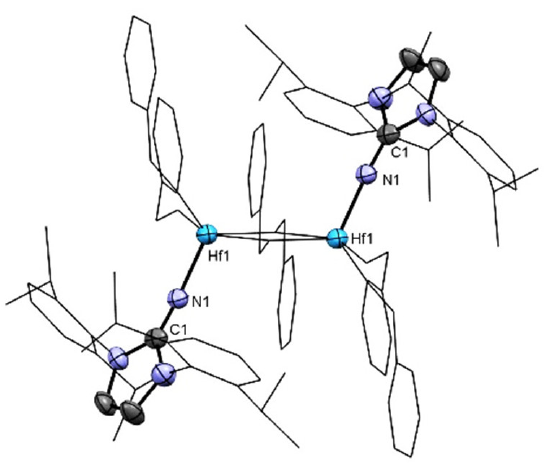
Figure 4. ORTEP drawing of 5 [(Im Dipp N) 2 Hf 2 (OBn) 6 ]. Hydrogen atoms are omitted for clarity. Selected bond lengths (Å) and angles (°): Hf-N1 = 1.971(7), Hf-O1 = 2.136 (5), Hf1-O1 = 2.198(6); Hf-O2 = 1.936(6), Hf-O3 = 1.958(7); N1-C1 = 1.251(10) Å; Hf-N1-C1 = 176.3(6), Hf-O1-Hf 1 = 113.2(2); O1-Hf-O1 1 = 66.8(2) (°).